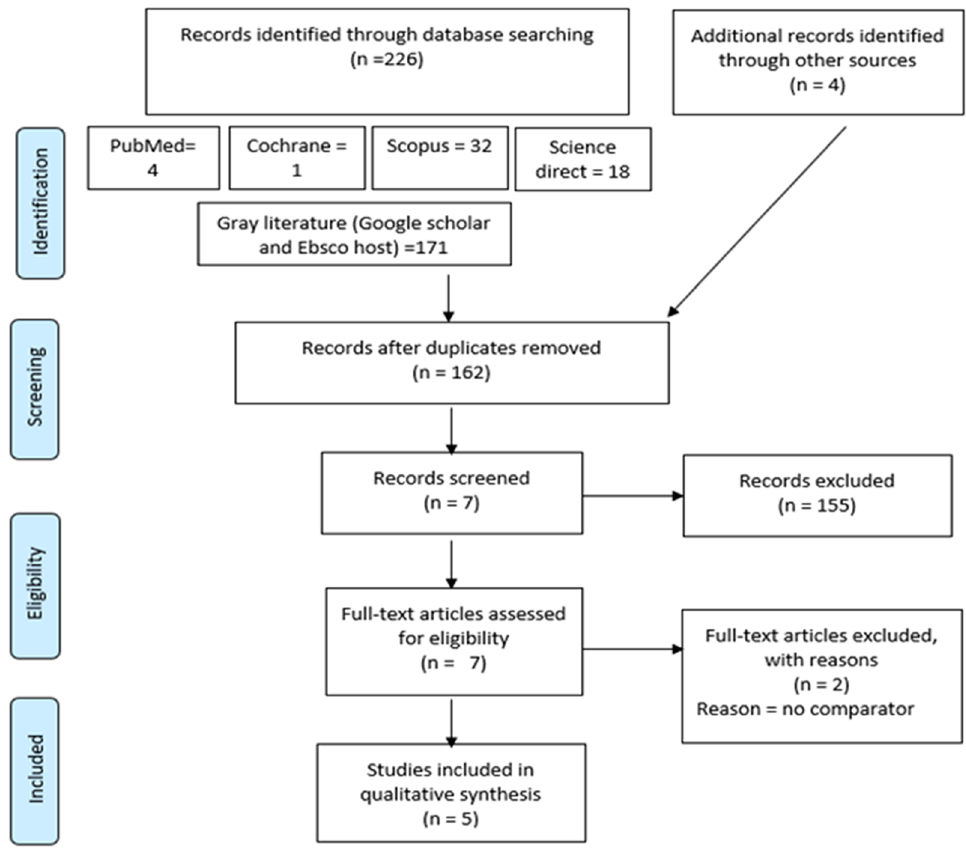
Fig. 1. PRISMA (Preferred Reporting Items for Systematic Reviews and Meta-Analyses) fl ow